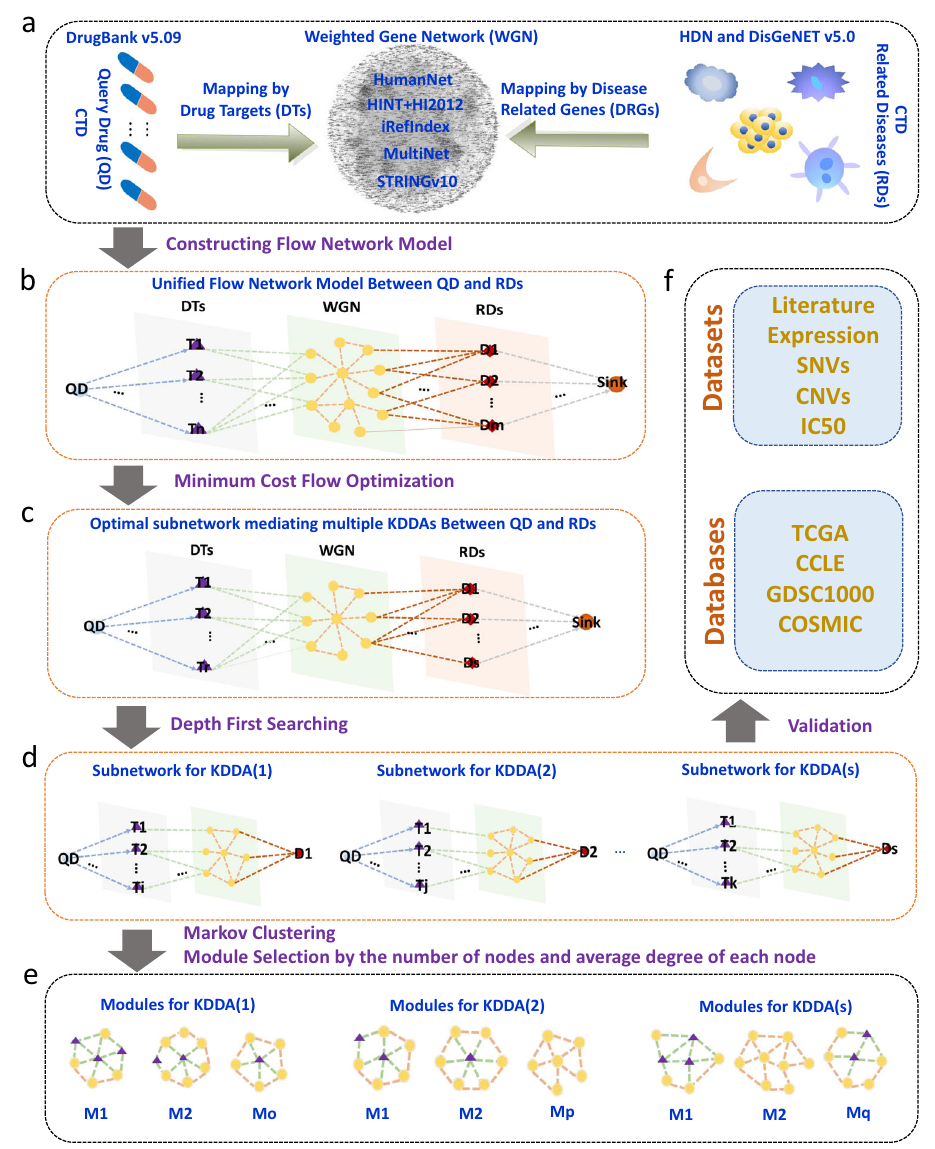
Fig. 1 Schematic illustration of KDDANet computational pipeline in SDrTDi context. a Mapping query drug (QD) and all its related diseases (RDs) into the weighted gene network (WGN) through known drug-target relationships and gene-disease associations. b Constructing a uni fi ed fl ow network model for each QD and RDs (multiple KDDAs). c Identifying the highest-probability gene subnetwork mediating multiple KDDAs by minimum cost fl ow optimization. d Identifying gene subnetwork mediating individual KDDA by depth- fi rst searching. e Identifying gene interaction modules mediating individual KDDA by Markov clustering (MCL). f Validating the prediction results of KDDANet by existing knowledge